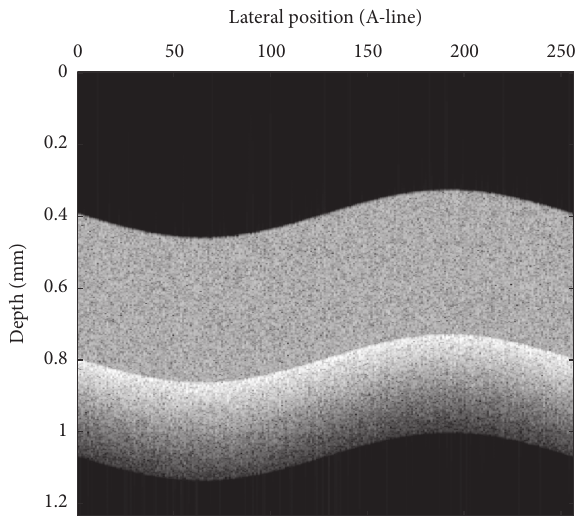
Figure 10: Simulation of the OCT signal intensity for a two-layer turbid sample. The intensity scale is